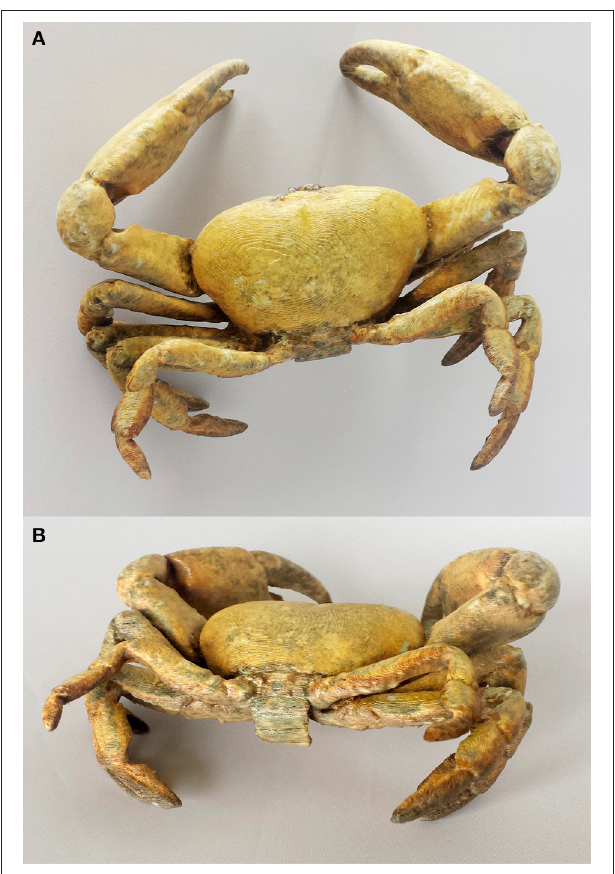
FIGURE 3 | 3D Printed paper model of Segozancia sp. crab (Keaveney et al., 2016). (A) Dorsal view (B) Caudal